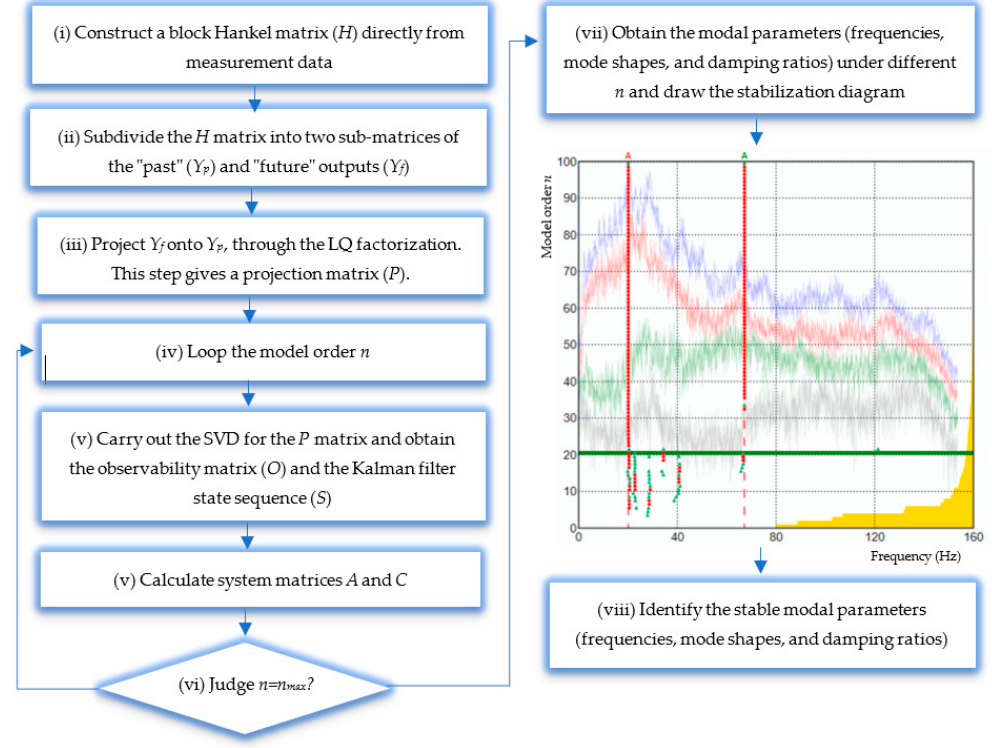
Figure 9. Logical diagram of damping ratio estimation based on the Stochastic Subspace Identification (SSI) method. Extracted from ARTeMIS Modal Pro [21].